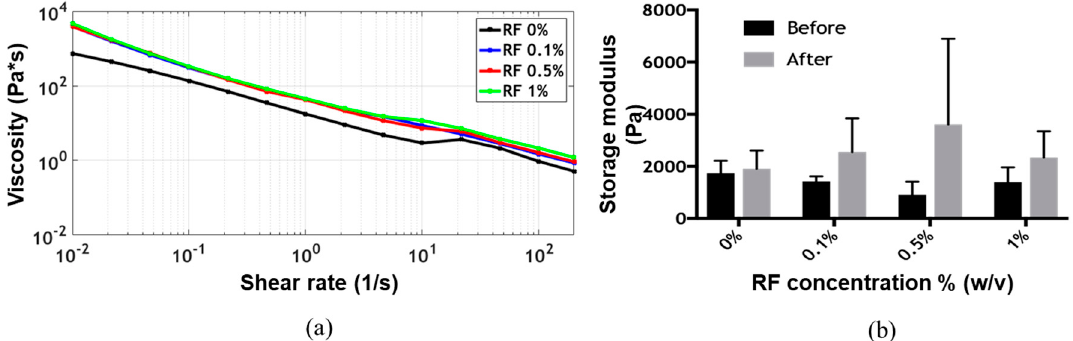
Figure 2. ( a ) Viscosity versus shear rate of the different formulations at 22 °C and ( b ) their storage modulus G’ before and after exposure to blue light at the same temperature.